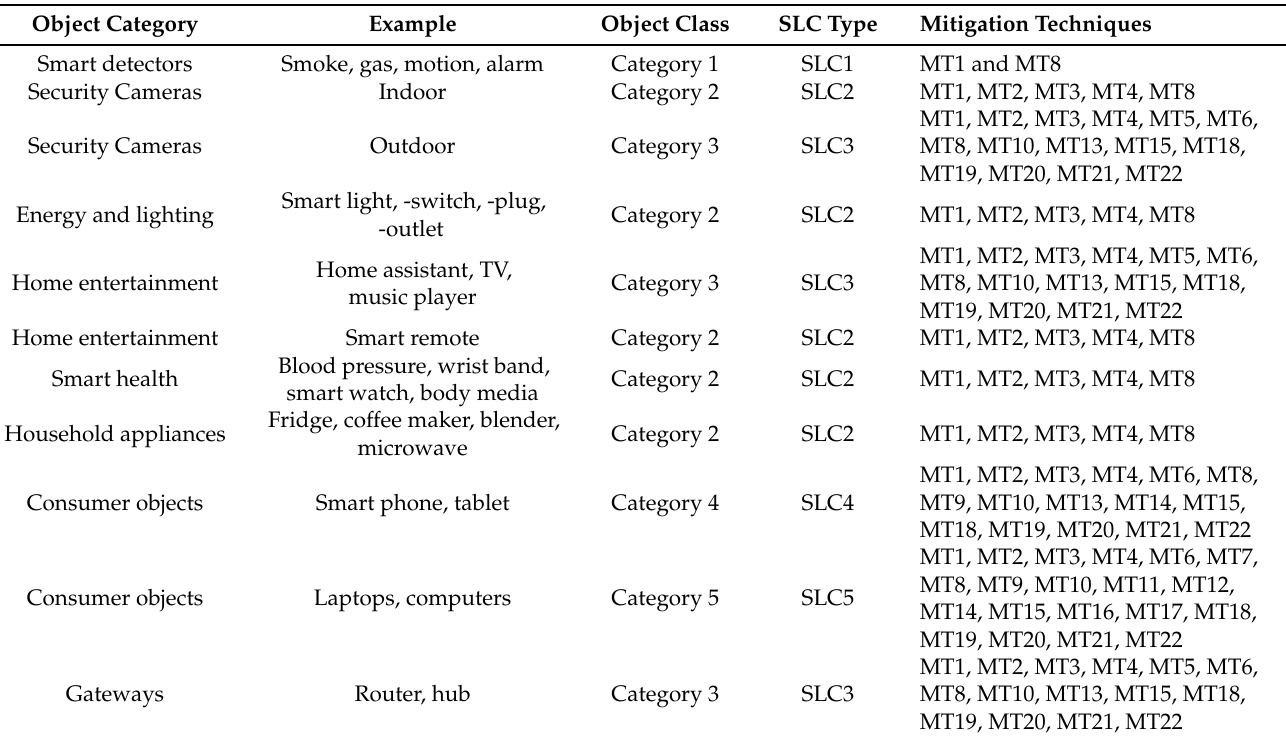
Table 13. A summary of smart home object classification, along with